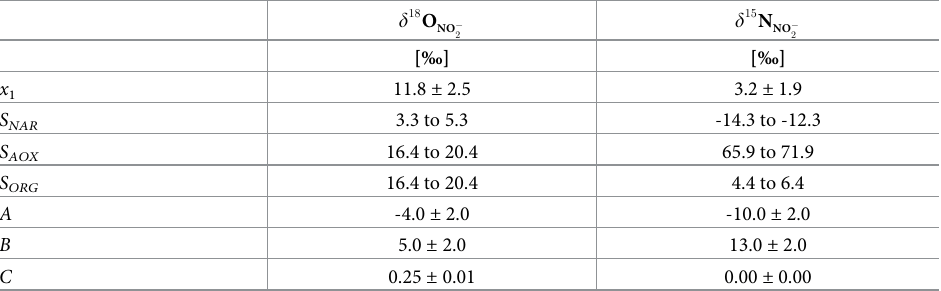
Table 8. Summary of input values for the FRAME model: Nitrite sample ( x ), 3 sources ( S given as ranges from/to), parameters representing isotope fractionation factors for nitrite reduction and oxidation ( A, B ) and extent of equilibrium δ 18 O ( C ) given as mean with standard